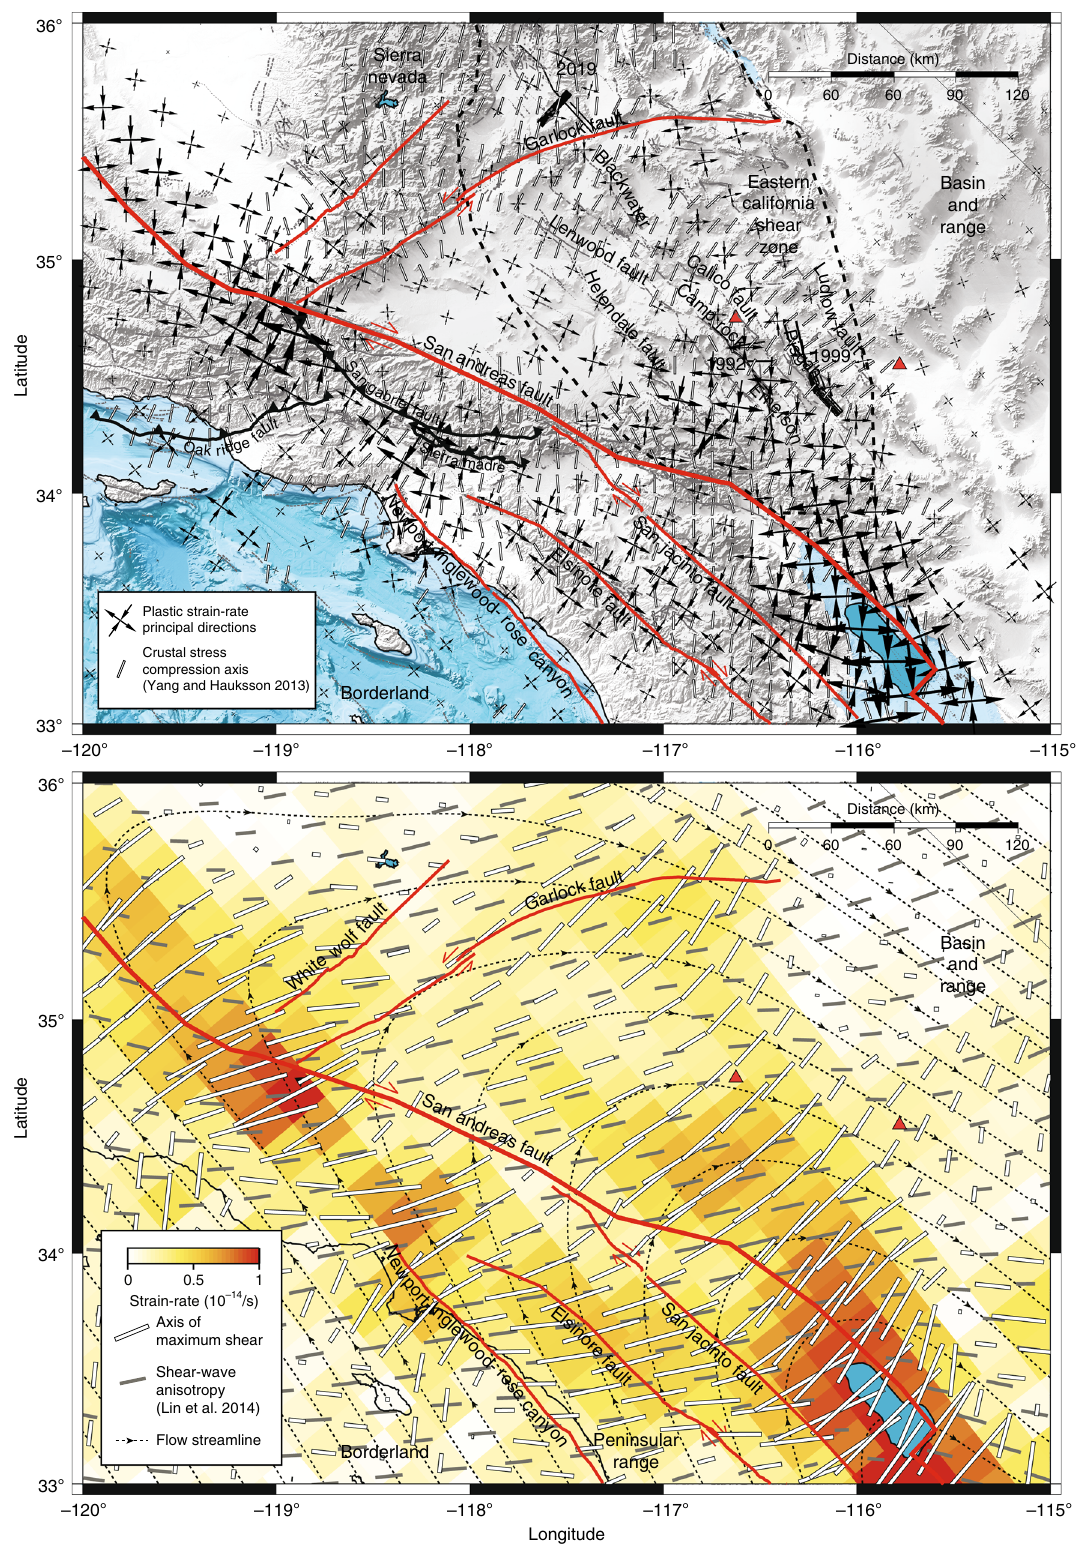
Fig. 6 Principal strains, faults, seismicity, and seismic anisotropy. The top panel shows the principal strain direction of plastic strain-rate in relation to the orientation of strike-slip and thrust faults, and in relation with the compression axis of seismicity 67 . The bottom panel shows the direction of maximum shear of the plastic strain-rate and fl ow streamlines in relation to the orientation of seismic anisotropy 31 . Red lines indicate strike-slip faults. Black lines with chevrons indicate major thrust faults. Red triangles indicate quaternary volcanos. Grey lines indicate quaternary faults. The dashed contour indicates the approximative extent of the Eastern California Shear